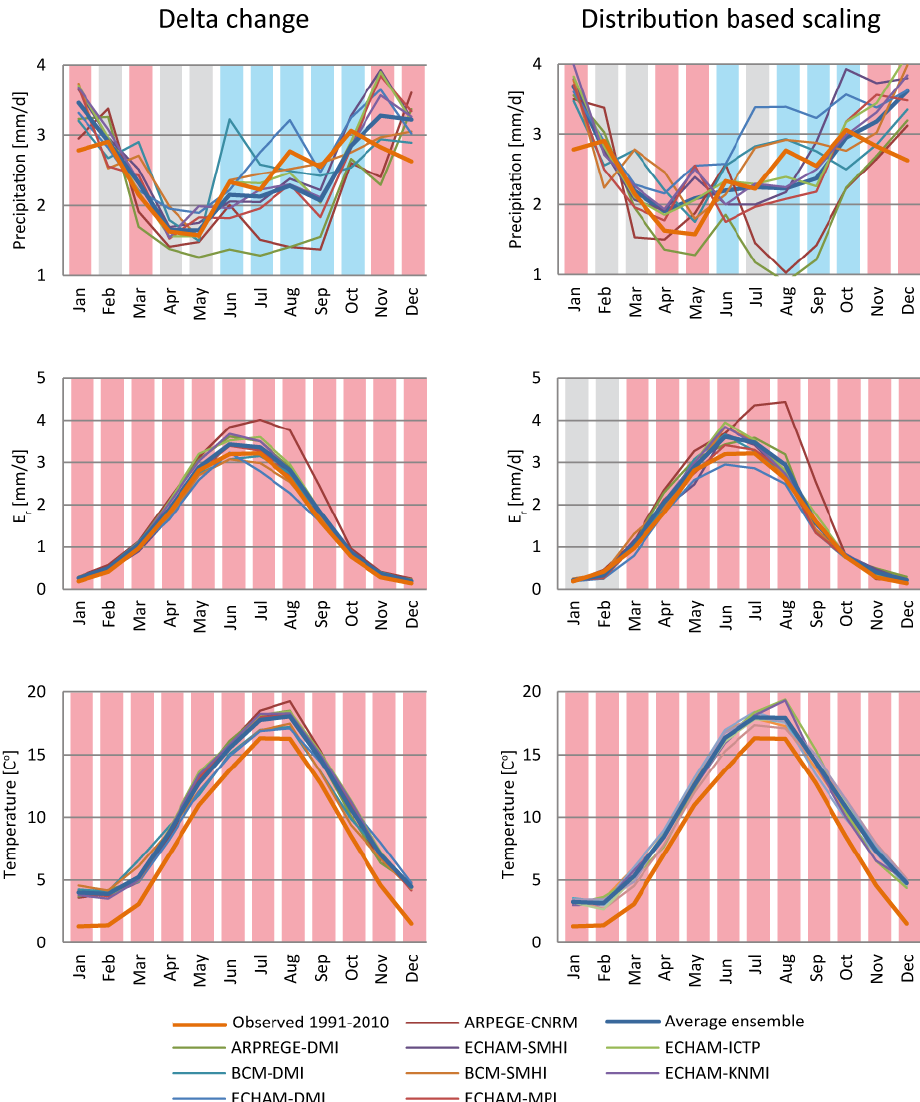
Fig. 7. Monthly average for precipitation, reference evapotranspiration ( E r ) , and temperature from the climate models for the period 2081– 2100 and observed for 1991–2010. Average ensemble values are calculated from the 9 ensemble members for the DC and DBS ensembles, respectively. Background bars illustrate months where the ensemble average show higher (red), reduced (blue) or unchanged (grey) values of precipitation, E r or temperature compared to the baseline period (1991-2010).